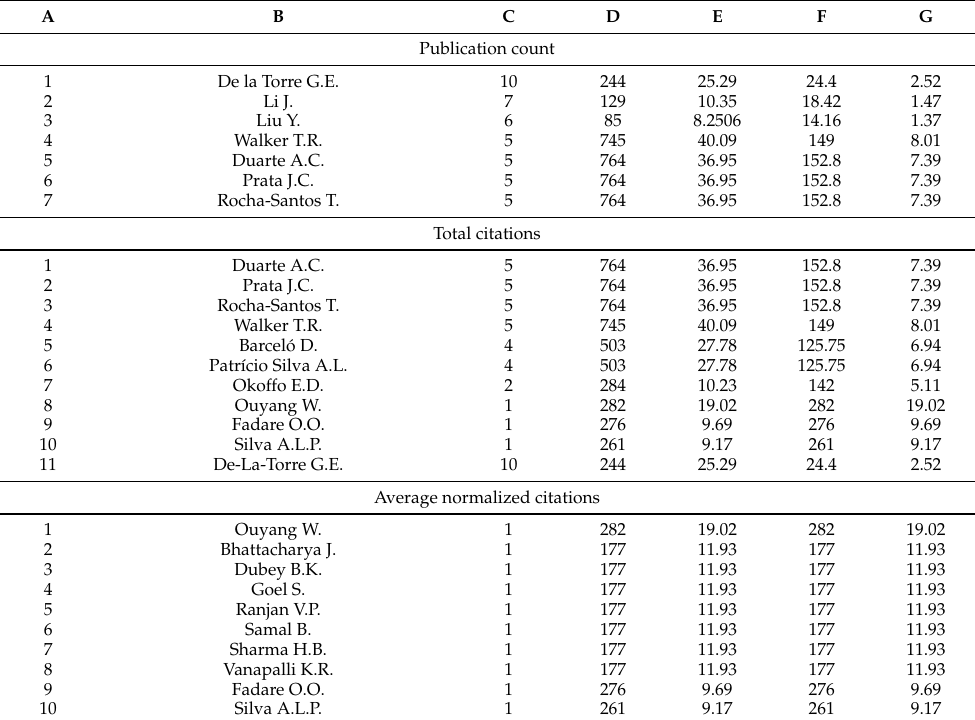
Figure 8. Relationship between the number of authors and the number of documents published. Table 3. Ranking of authors with more importance in the field in terms of total publication count, total citations, and average normalized